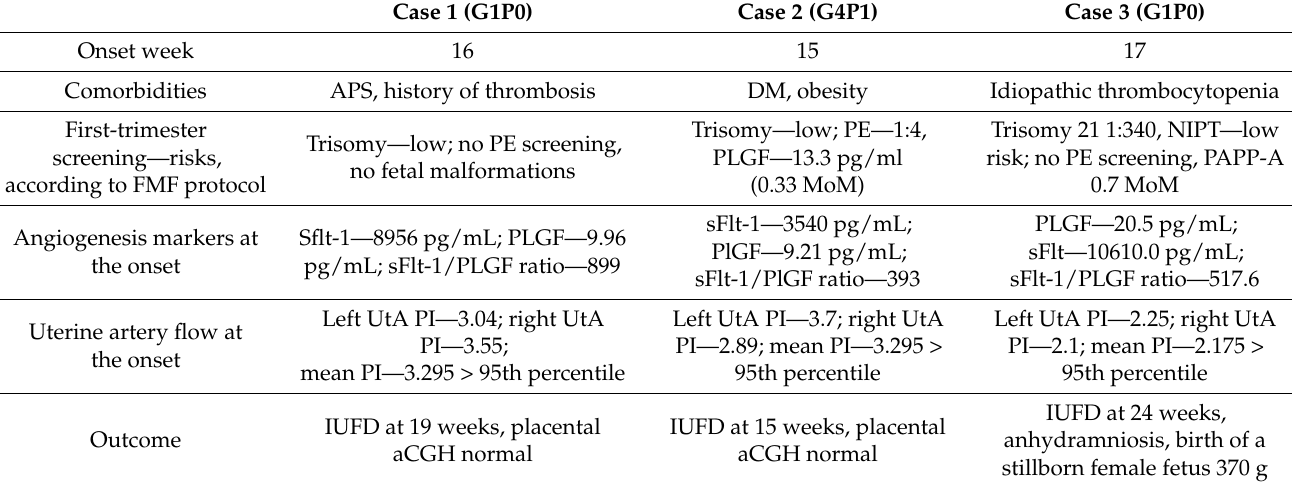
Table 1. Presentation of cases. APS—antiphospholipid syndrome, FMF—Fetal Medicine